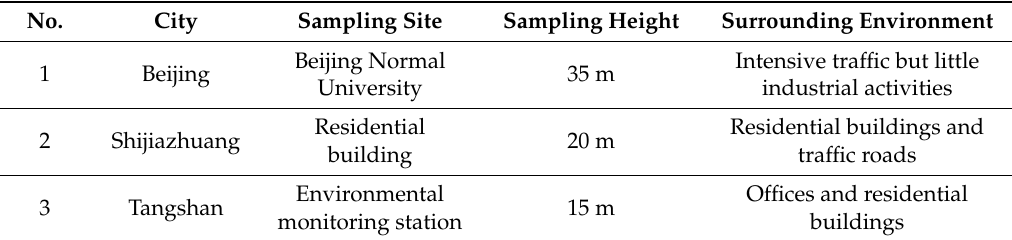
Table 2. Sampling